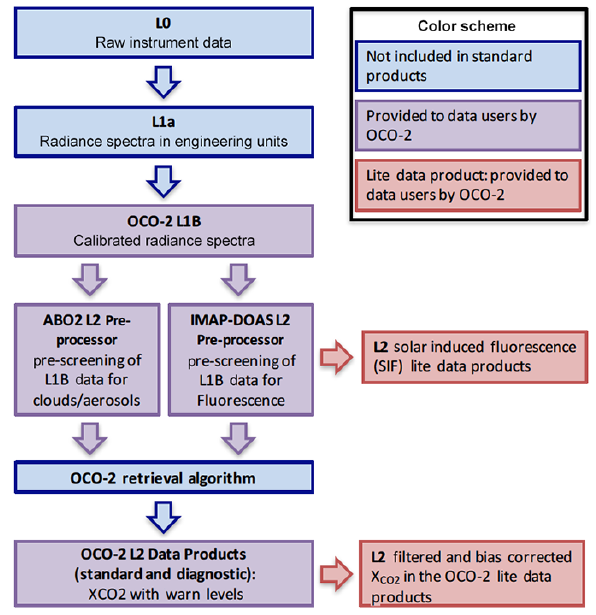
Figure 2. OCO-2 data processing